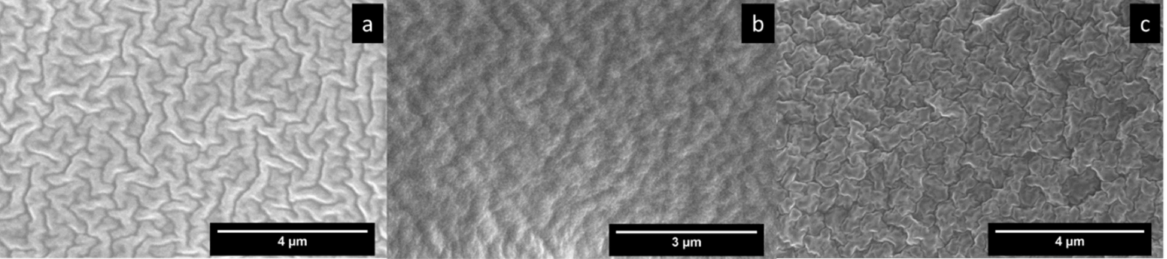
Figure 1. Cross-section morphology of samples A ( a ), B ( b ), and C ( c ); 4 µ m scale.